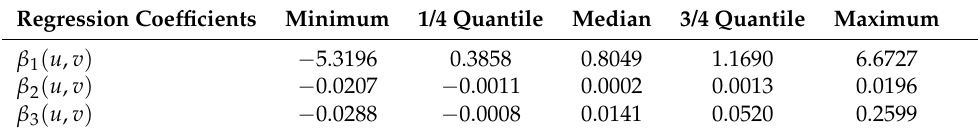
Table 4. Regression coefficients estimation with the adaptive bandwidth matrix H . Regression